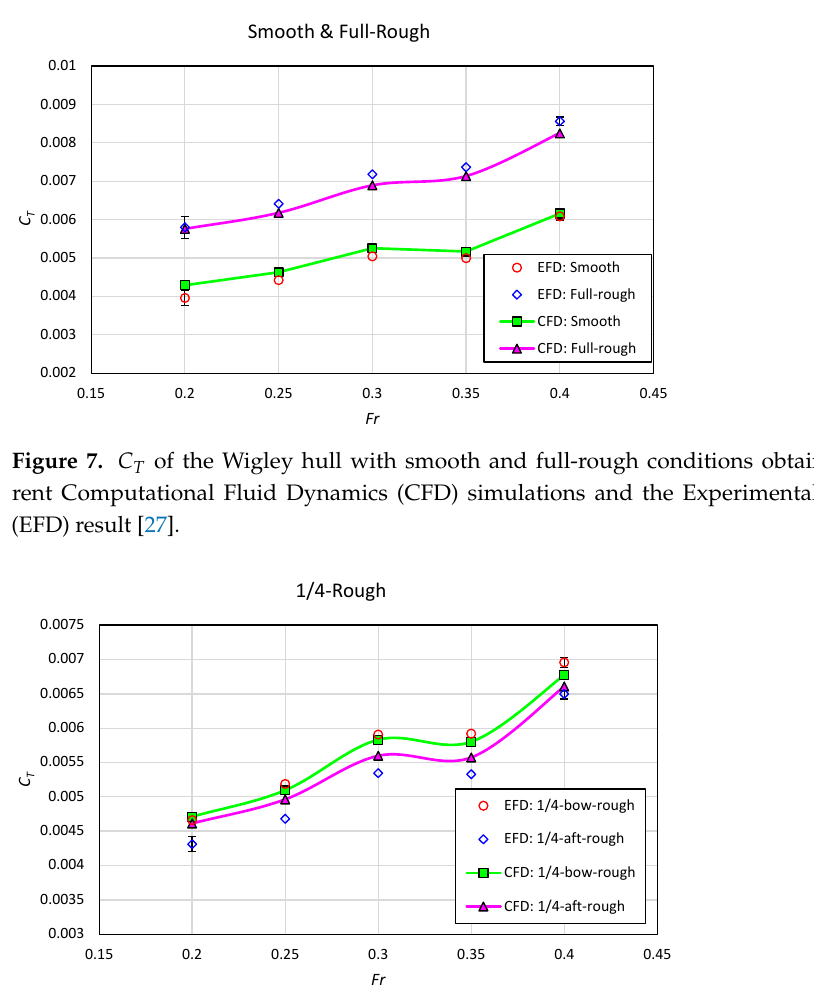
Figure 8. C T of the Wigley hull with 1 -bow-rough and 1 -aft-rough conditions obtained from the 4 4 Figure 8. 𝐶 (cid:3021) of the Wigley hull with ¼-bow-rough and ¼-aft-rough conditions obtained from the current CFD simulations and the EFD result [27]. current CFD simulations and the EFD result [27].